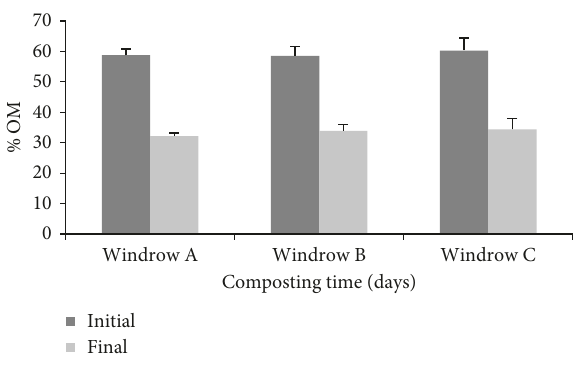
Figure 4: Organic matter degradation during the composting process.